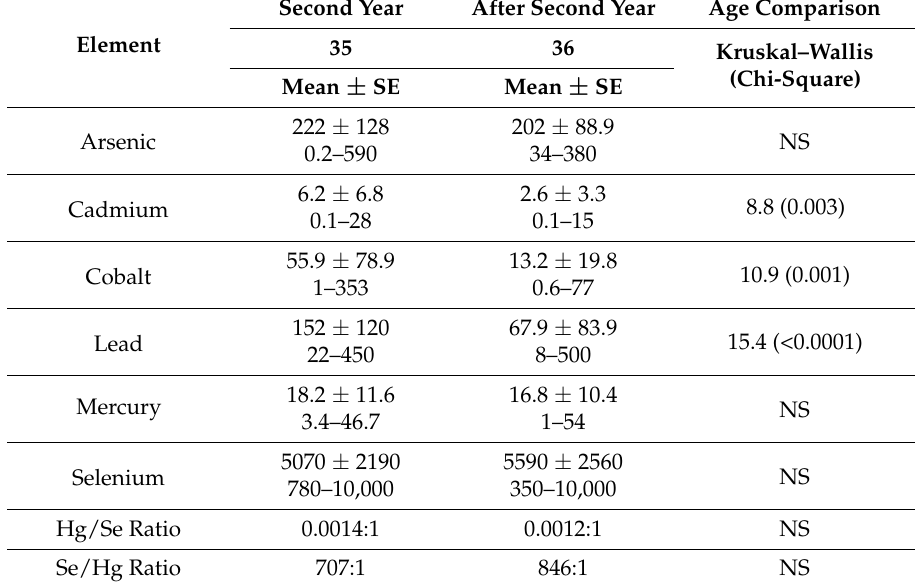
Table 1. Mean (+standard error) element levels in whole blood collected from semipalmated sandpipers in Suriname, April 2013, and results of comparisons between age classes (second-year versus after second-year). Mean values are given in parts/billion (1 ppb = 1 ng/g). NS = not significant.